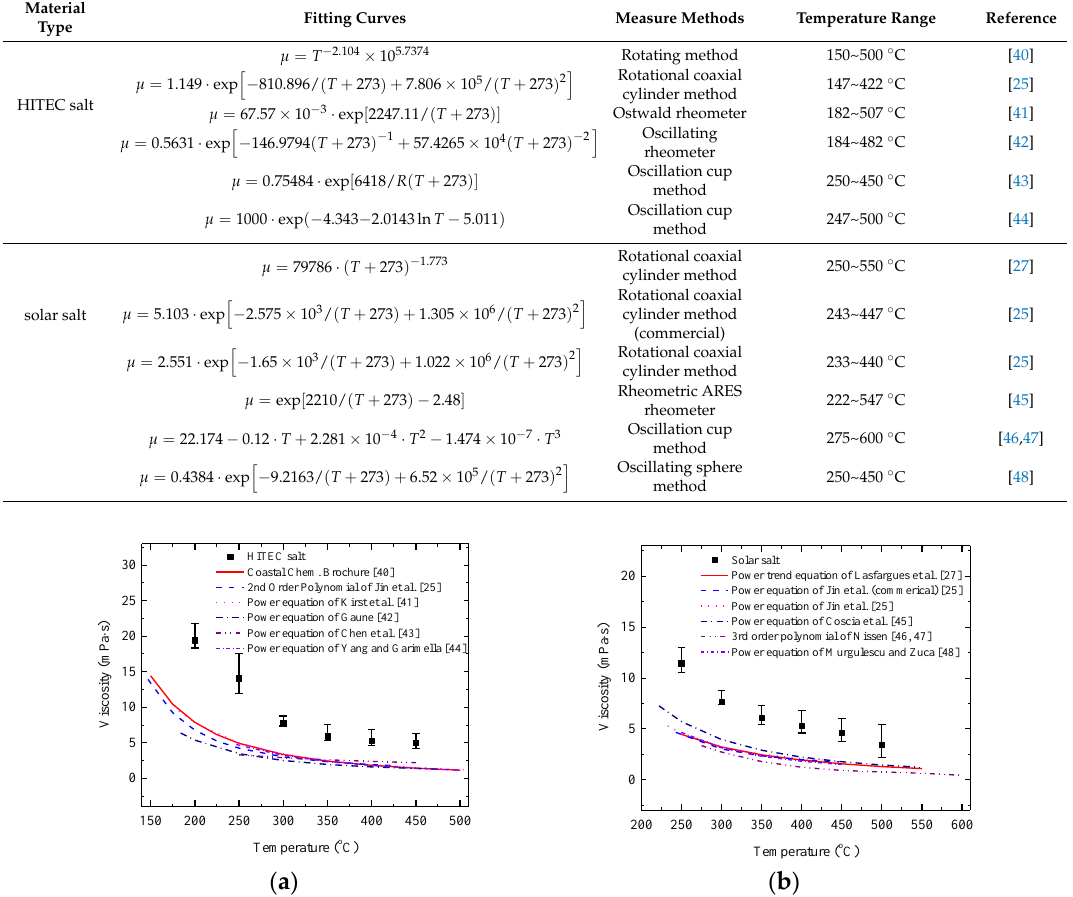
Figure 6. Comparison of present experimental results of viscosities with experimental data reported in the literature [25,27,40–48]. ( a ) HITEC salt; ( b ) solar